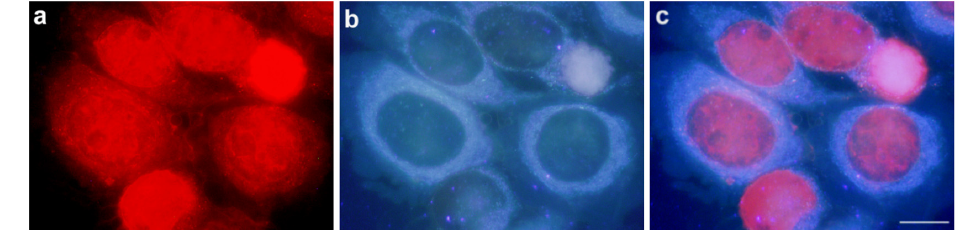
Figure 7. HeLa cells treated with 0.2 µ M DOXO for 24 h and observed under fluorescence microscope. ( a ) Cells observed under green excitation; ( b ) the same field observed under UV excitation;